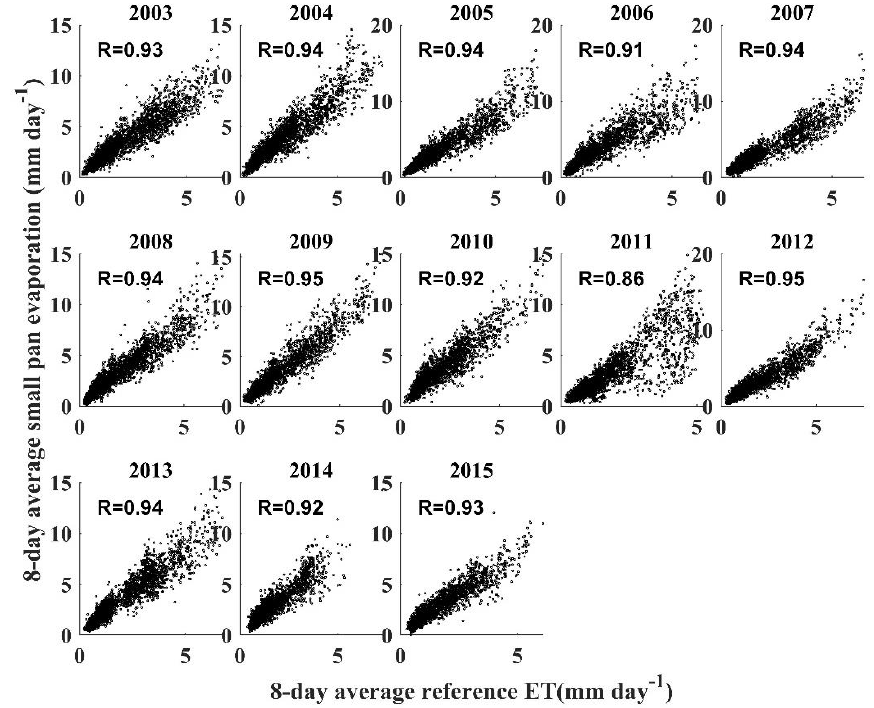
Figure 7. Evaluation of the reference ET simulated by the PM formula. The blue line is the fitted line.